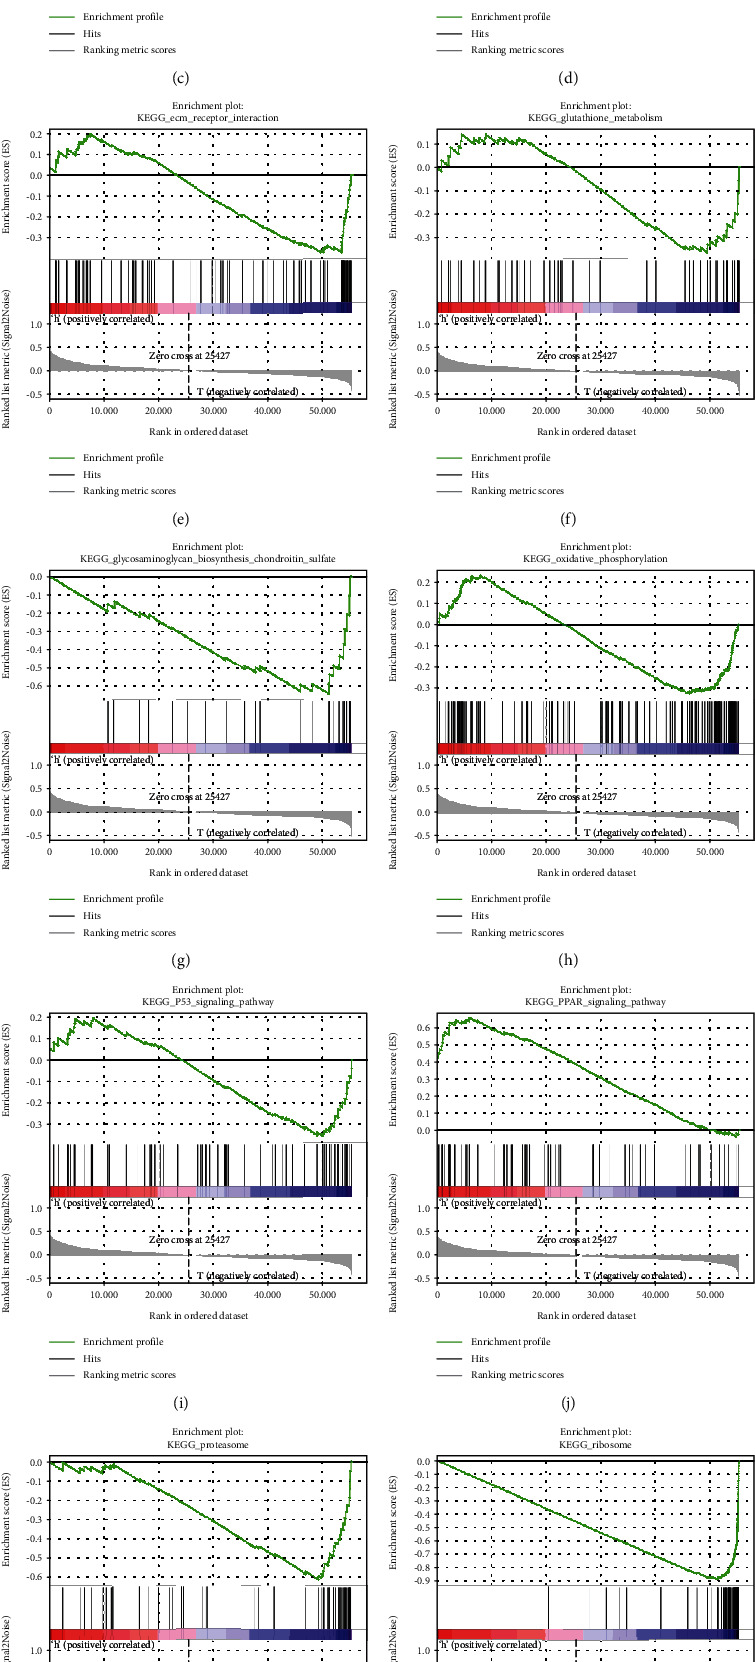
GSEA analysis for CPT1A in KIRC. (a) Adipocytokine signaling pathway. (b) Citrate cycle/TCA cycle. (c) Complement and coagulation cascades. (d) Cytokine-cytokine receptor interaction. (e) ECM receptor interaction. (f) Glutathione metabolism. (g) Glycosaminoglycan biosynthesis chondroitin sulfate. (h) Oxidative phosphorylation. (i) P53 signaling pathway. (j) PPAR signaling pathway. (k) Proteasome. (l) Ribosome. (m) Systemic lupus erythematosus.